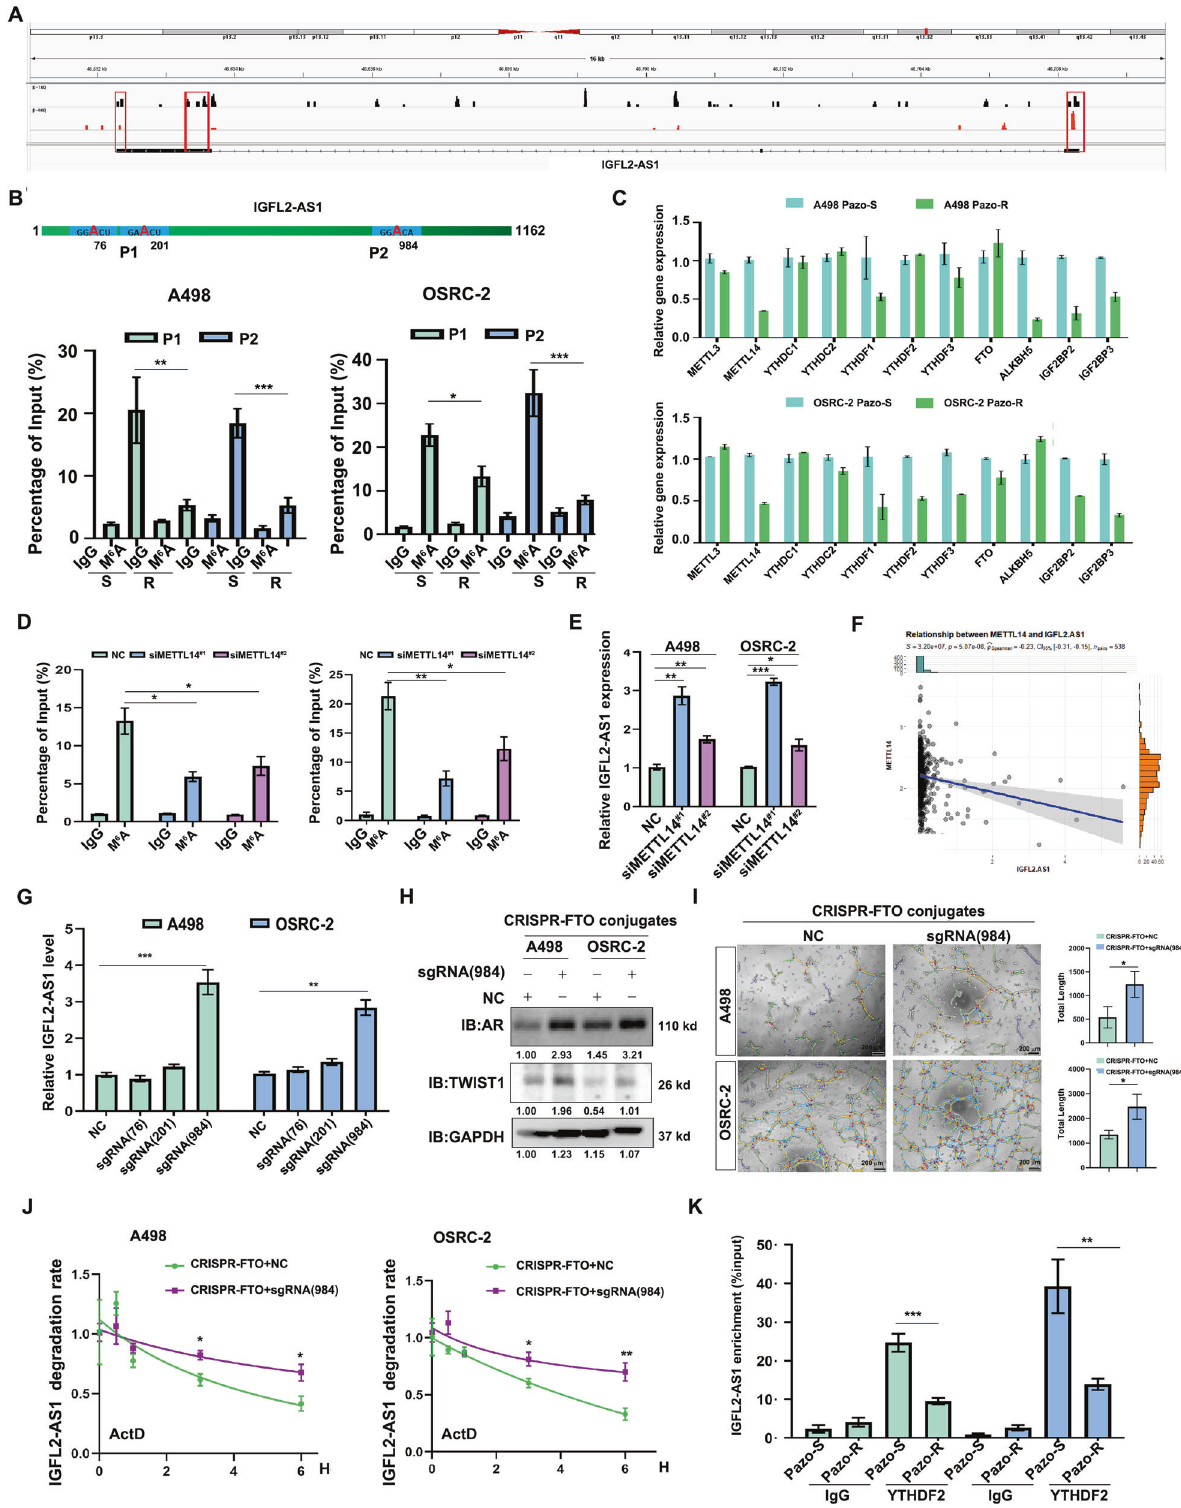
to suppress tumor growth (Fig. 7A, B), enforcing the drug-resistant property of this ccRCC tumor. However, combined administration of pazopanib and enzalutamide signi fi cantly suppressed ccRCC tumor growth, suggesting targeting AR with its inhibitor enzalutamide could enhance pazopanib ef fi cacy (Fig. 7A, B). We then sacri fi